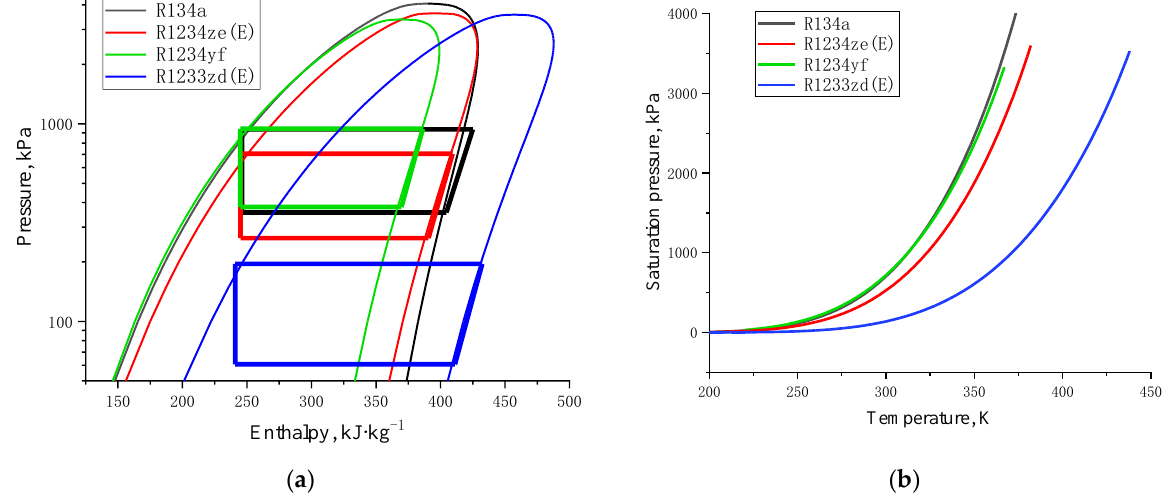
Figure 1. Thermodynamic figure comparison of 4 refrigerants: ( a ) Pressure-enthalpy diagram, ( b ) Pressure-temperature diagram.